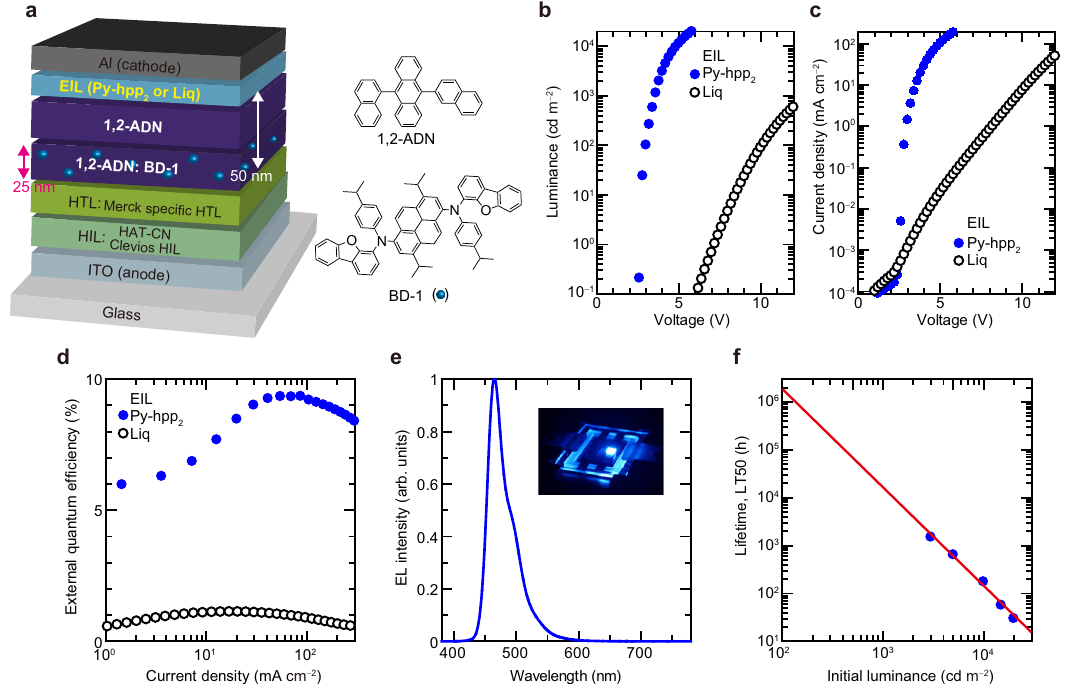
Fig. 4 Demonstration of an innovative blue OLED. a Multilayer structure of the OLED, chemical structure of the materials used in the EML. b , c Luminance – voltage and current density – voltage characteristics of blue fl uorescent OLEDs with different EILs. d EQE traces of devices with different EILs. e EL spectrum of a blue OLED with Py-hpp 2 . The inset is a photograph of the blue OLED. f Lifetime extrapolation for the blue OLED with Py-hpp 2 . Data points are obtained at different initial luminance